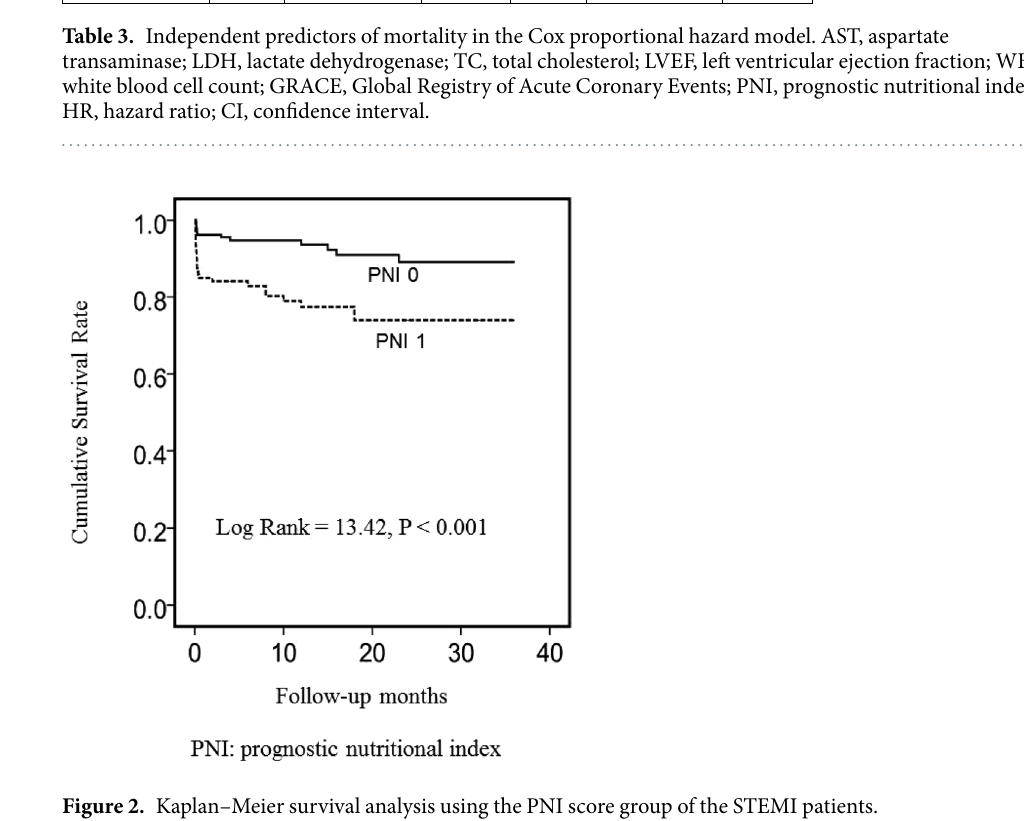
Figure 2. Kaplan–Meier survival analysis using the PNI score group of the STEMI